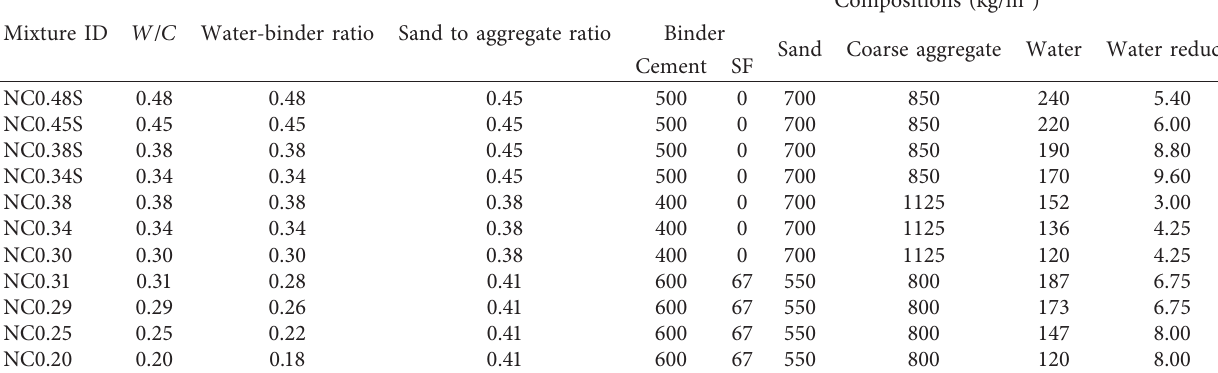
Table 3: Mixture proportions of normal concrete.